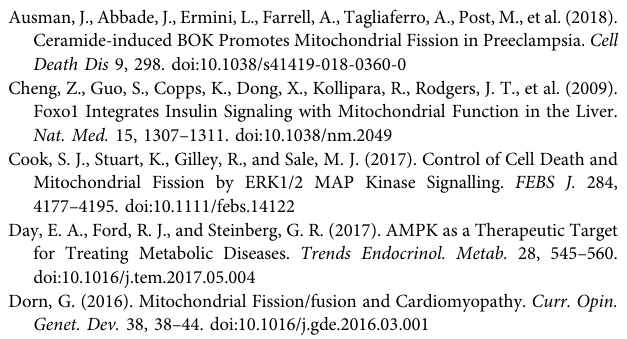
aortic constriction; TMZ, Trimetazidine. Supplementary Figure S4 | Trimetazidine didn ’ t alter cardiac lipid metabolism in vivo. (A,B) The cardiac TC and TG levels after TMZ treatment in 4 weeks. TC, triglyceride. TG, cholesterol. (C) The relative mRNA levels of cardiac lipid metabolism gene levels, including CD36, PPAR α (peroxisome proliferator- activated receptor-alpha), FASN (fatty acid synthase), CPT1a (carnitine palmitoyl-transferase-1a), CPT1b (carnitine palmitoyl-transferase-1b), ACC1 (acetyl CoA carboxylase 1) in myocardium after TMZ treatment in 4 weeks. (D) Representative western blots of cardiac lipid metabolism protein and corresponding quantitative results. ** p < 0.01, vs indicated groups. TAC, Transverse aortic constriction; TMZ, Trimetazidine. Supplementary Figure S5 | Trimetazidine didn ’ t alter the protein expression of Glut1. (A,B) Representative western blots of Glut1 and corresponding quantitative